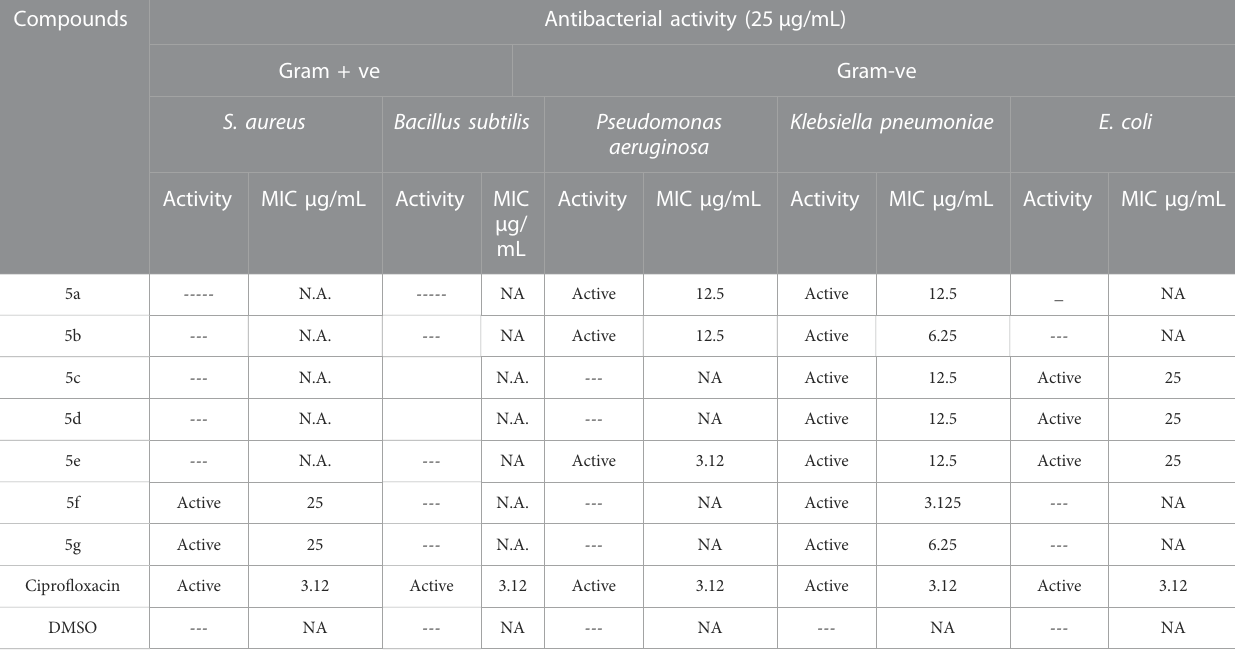
TABLE 2 Antibacterial evaluation of the synthetic compounds of Library compounds (5a-5g) against gram-positive and gram-negative bacteria and their MIC values.